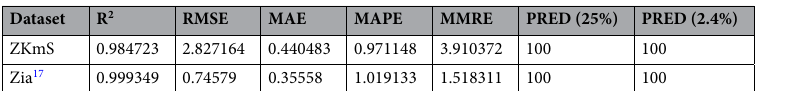
Table 7. ANFIS-EEBAT performance metric